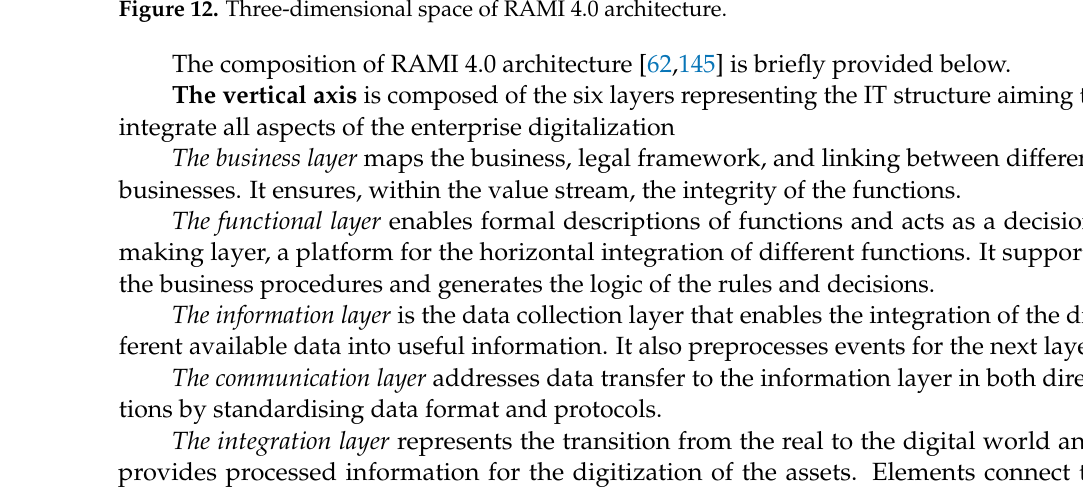
Figure 12. Three-dimensional space of RAMI 4.0 architecture.